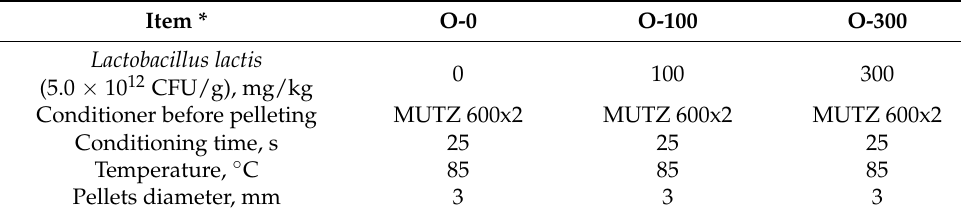
Table 2. The parameters of feed processing of the diets. Item * O-0 O-100 O-300 Lactobacillus lactis 0 100 (5.0 × 10 12 CFU/g), mg/kg Conditioner before pelleting MUTZ 600x2 Conditioning time, s Temperature, ◦